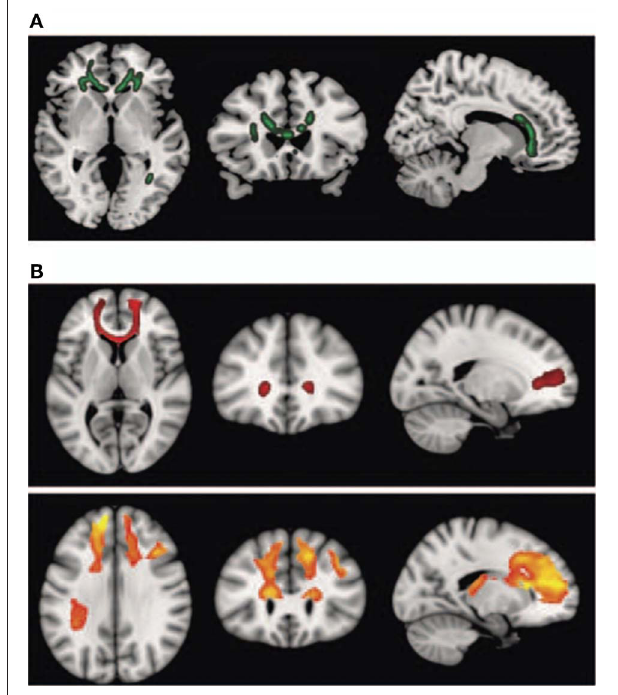
FIGURE 4 | Diffusion tensor imaging (DTI) findings. Top panel: (A) shows areas of significant fractional anisotropy (FA) reduction in the schizophrenic patients identified using Tract-based Spatial Statistics analysis thresholded at p = 0 . 01. Bottom panels (B) show areas of structural connectivity that differed significantly between the schizophrenic patients and controls, on the basis of the seed placed in the genu of the corpus callosum (upper, shown in red), and the seeds placed in the body of the corpus callosum, right and left (lower, shown in orange). A threshold of p = 0 . 05 corrected was used for this analysis. The right side of the image represents the left side of the brain. Reprinted from Pomarol-Clotet et al. (2010). Medial prefrontal cortex pathology in schizophrenia as revealed by convergent findings from multimodal imaging. Mol. Psychiatry 15, 823–830 with permission from Macmillan Publishers